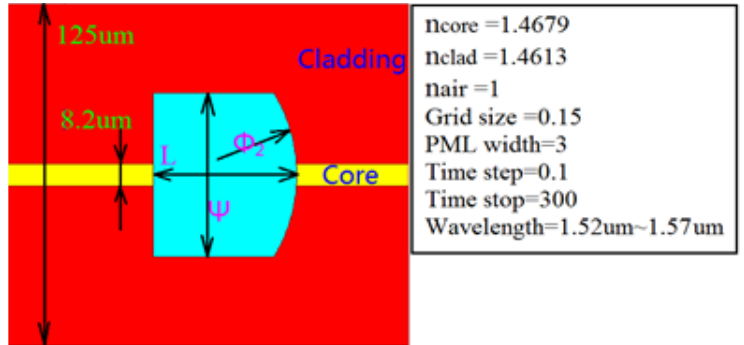
Figure 4. The simulation model of microcavity structure and parameter settings (the refractive index of the core is 1.4679; the refractive index of the cladding is 1.4613; the refractive index of air is 1; the wavelength range is 1520~1570 nm; the curvature radius of reflective surface II is φ 2 , microcavity wall is γ , microcavity diameter is ψ , microcavity cavity length is L ).